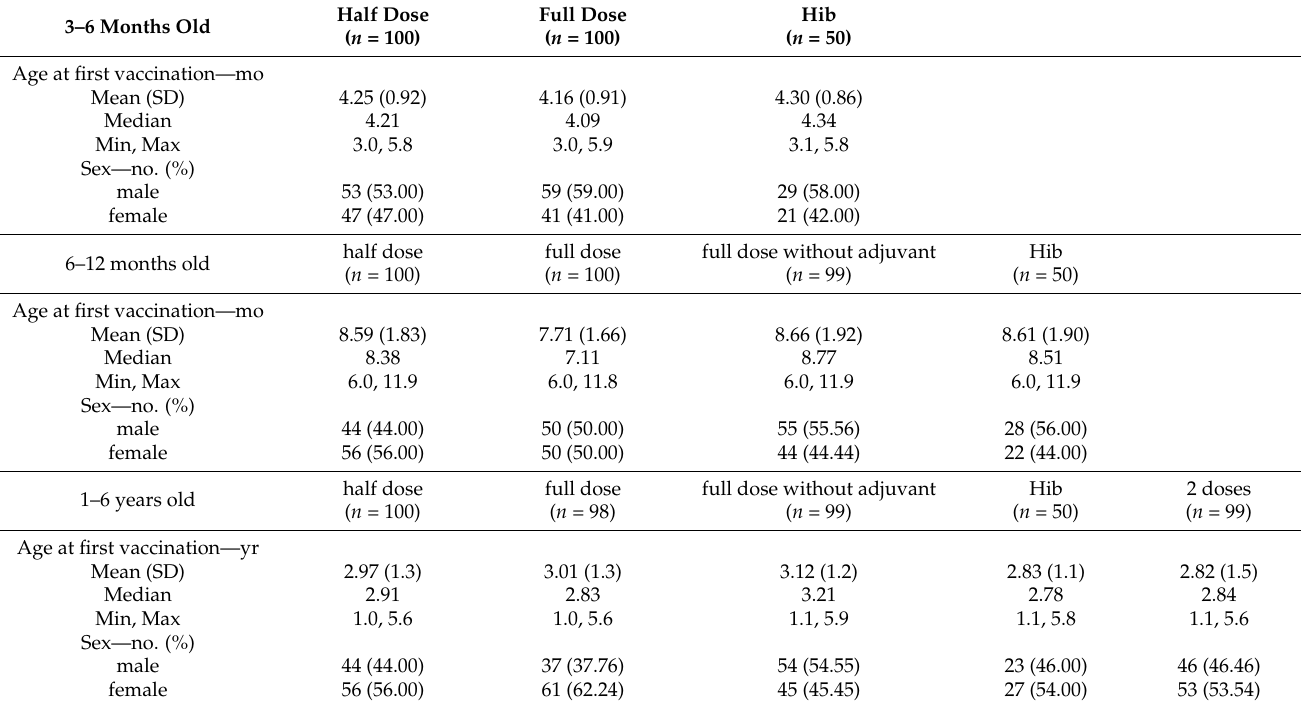
Table 1. Demographic Characteristics of the